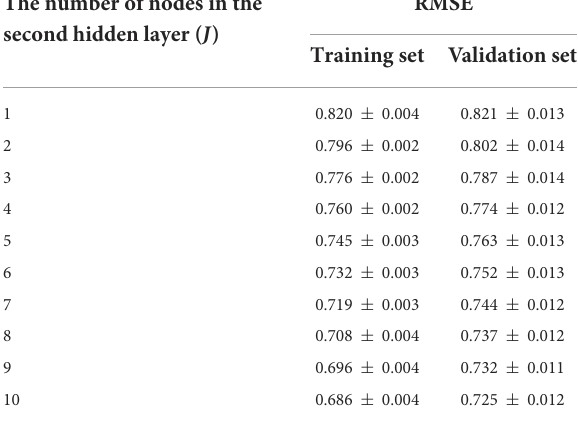
TABLE 1 The mean RMSE for each model. The number of nodes in the second hidden layer ( J )